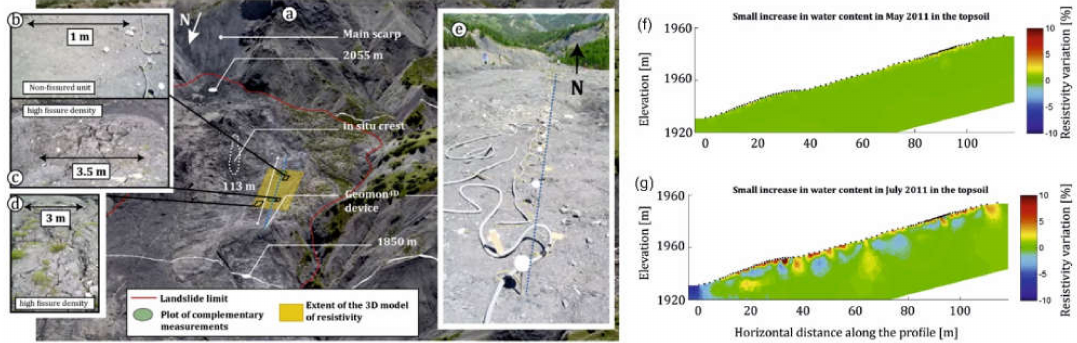
Figure 4. The map above ( a ) shows the location of the investigations carried out on the Super-Sauze landslide (Southeast France). The slope is characterized by non-fissured unit ( b ) and areas affected by a high fissure density ( c , d ). The dashed blue line ( e ) indicates the position of the GEOMON 4D system. The images ( f , g ) illustrate the soil cooling effect due to the rainwater. The percentage change in soil electrical resistivity after a small rainfall event could be due to the difference between rain and initial soil temperature (after [78]).